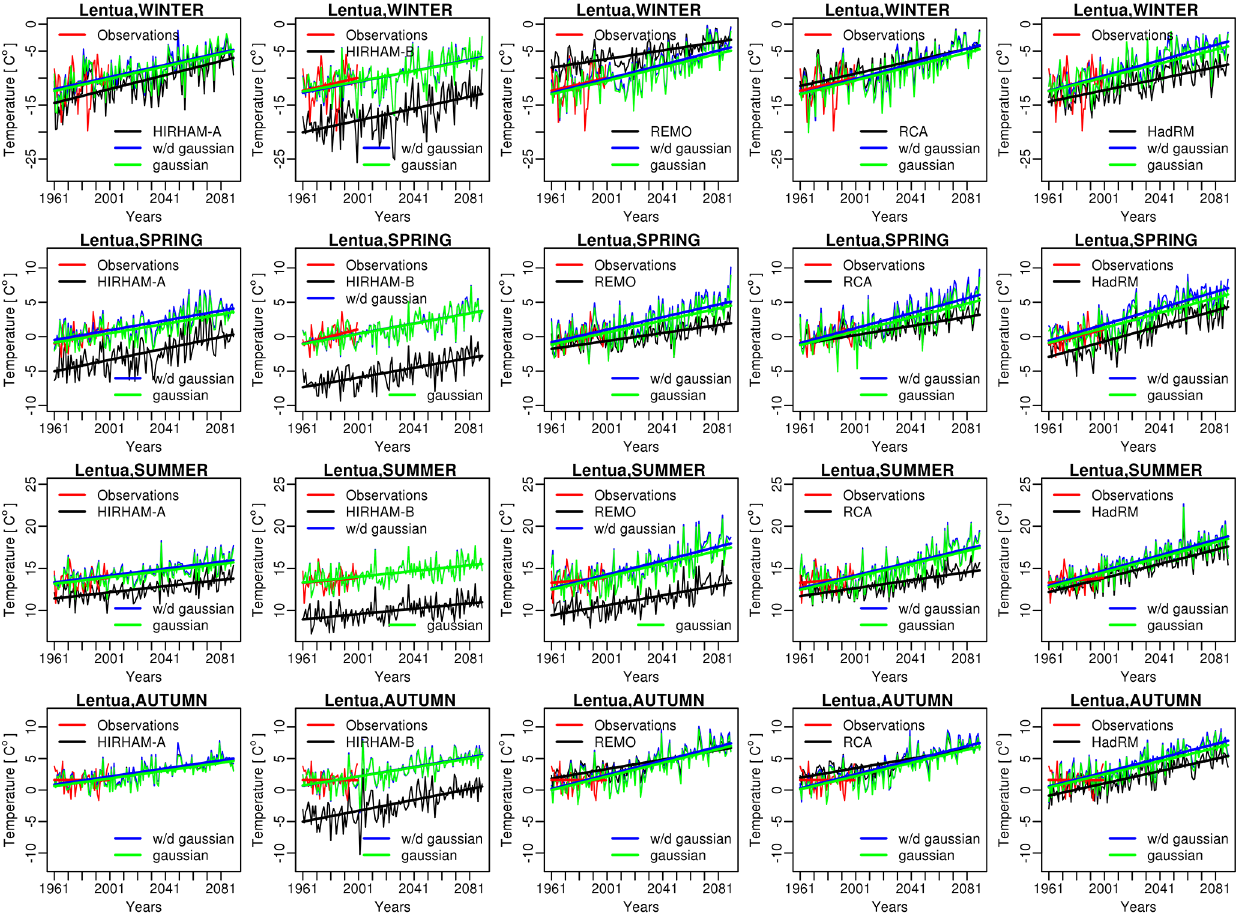
Figure 9. Seasonal trends in observed (red, 1961–2000) and RCM simulated daily temperatures in Lentua basin during 1961–2090. Uncor- rected RCM daily temperatures in black, temperatures adjusted with wet–dry separation in blue and without wet–dry separation in